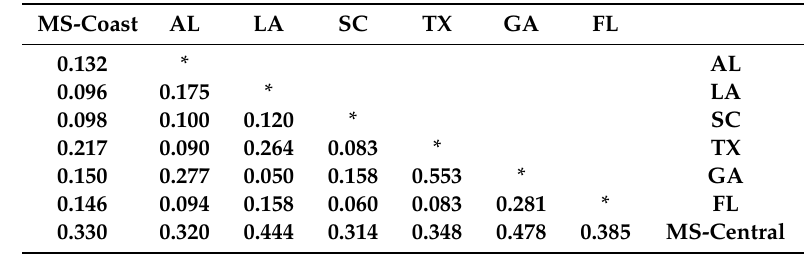
Table 3. Analysis of molecular variance (AMOVA) where two groups were inferred from the STRUCTURE analysis. Source of Variation